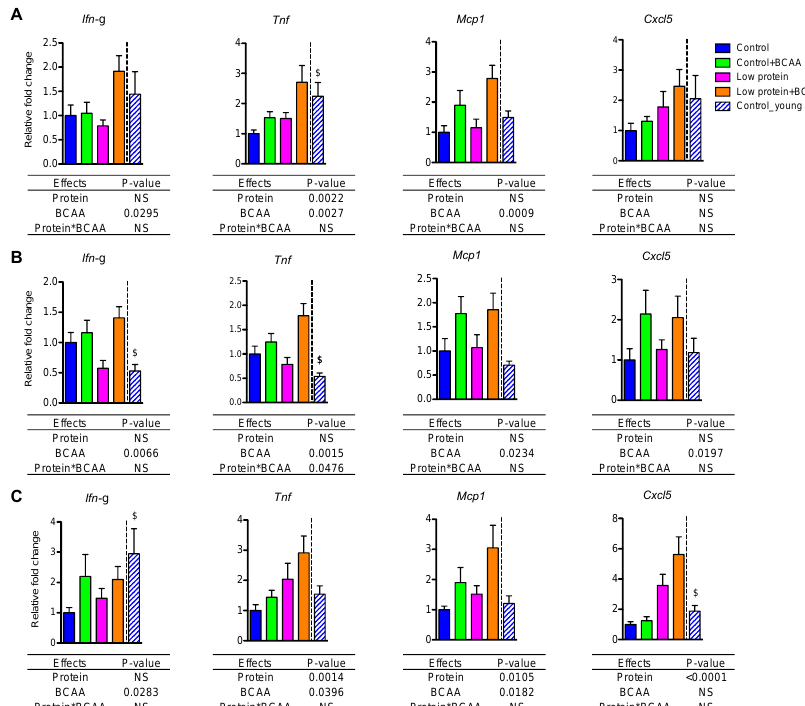
Figure 4. BCAA supplementation induced Ifn- γ , Tnf, and Mcp1 expression in white adipose tissue and liver, while Cxcl5 expression was differentially regulated by diets across tissues. The relative gene expression levels of pro-inflammatory Ifn- γ , Tnf, Mcp1, and Cxcl5 were measured in IWAT ( A ), epididymal white adipose tissue (EWAT) ( B ), and liver ( C ). Data represent mean ± SEM ( n = 8–12 mice per group). Statistical analyses of main effects (protein and BCAA) and interactions (protein*BCAA) are shown below each graph. $ p < 0.05 for young vs. old control groups.